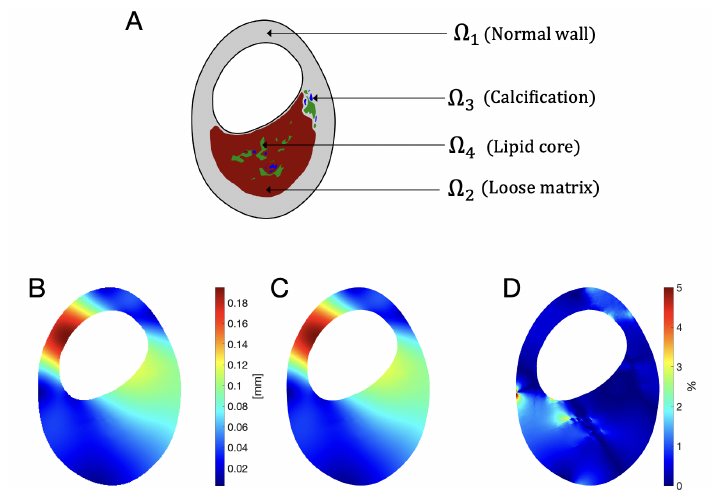
Ω k displacements distribution k = 1